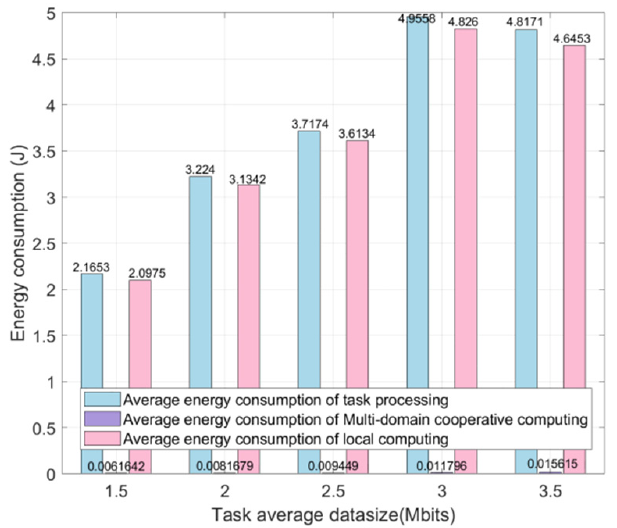
Figure 5. Variations in energy consumption of multiple task processing stages for various task sizes.